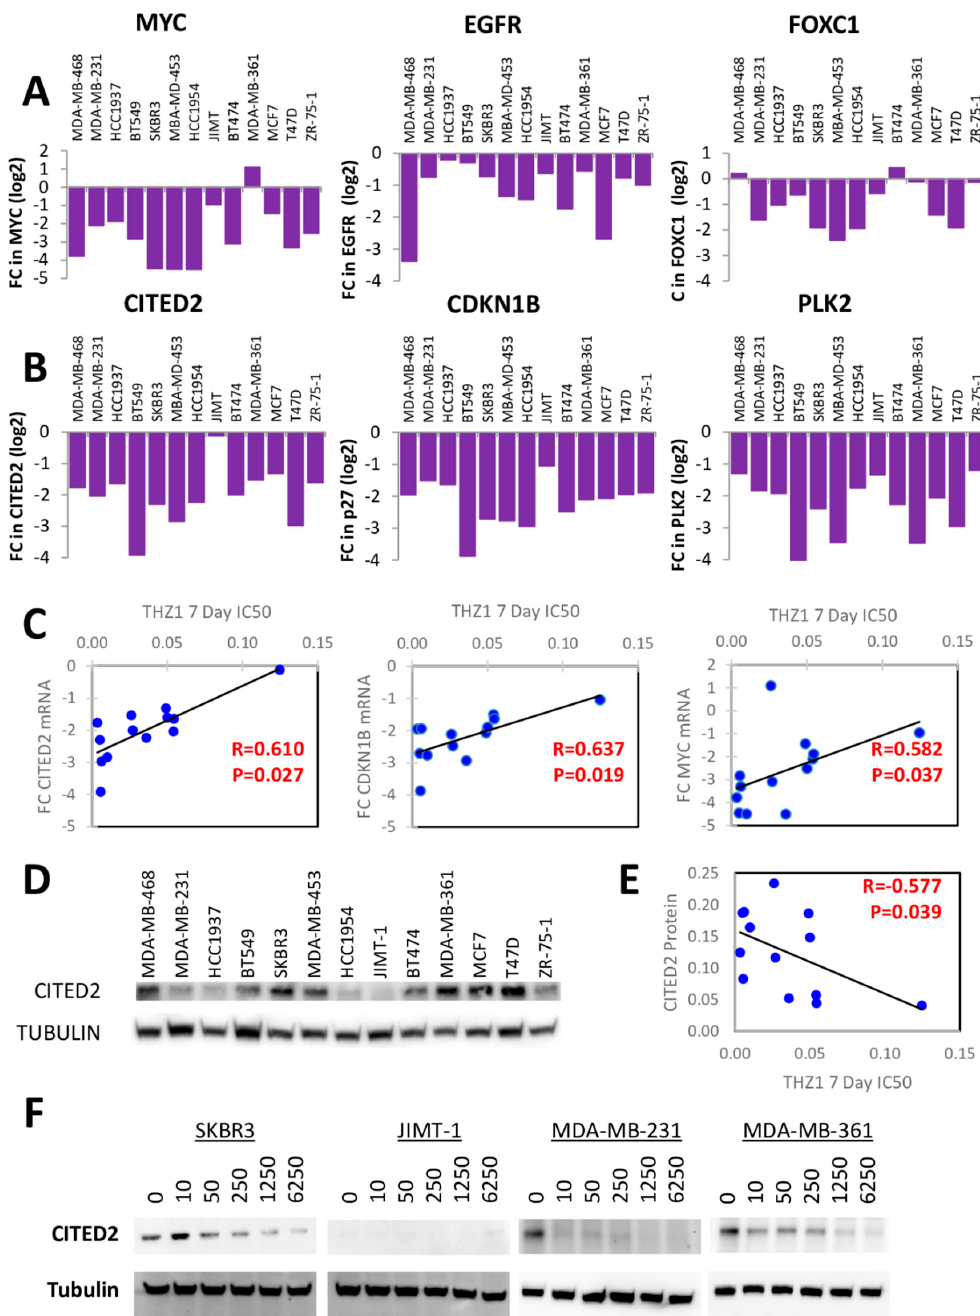
Figure 8. THZ1 treatment significantly alters the expression of several genes in different breast cancer cell lines. ( A – B ) Fold change (FC) in mRNA expression of MYC, EGFR, FOXC1, CITED2, CDKN1B, and PLK2 following treatment with 250nM THZ1 for 6 h, as compared to vehicle treated cells. ( C ) Bi-variant scatter graphs and Spearman rank correlations comparing fold change (FC) in CITED2 mRNA expression following THZ1 treatment with THZ1 sensitivity at 7 days in the cell line panel. ( D ) Immunoblotting for basal CITED2 protein expression (with α -tubulin as loading control) in cell line panel. ( E ) Bi-variant scattergraphs and Spearman rank correlations comparing CITED2 protein expression and sensitivity to THZ1 at 7 days in the cell line panel. ( F ) Immunoblotting for CITED2 protein expression (with α -tubulin as loading control) following treatment with increasing concentrations of THZ1 (nM concentrations) for 4 h.